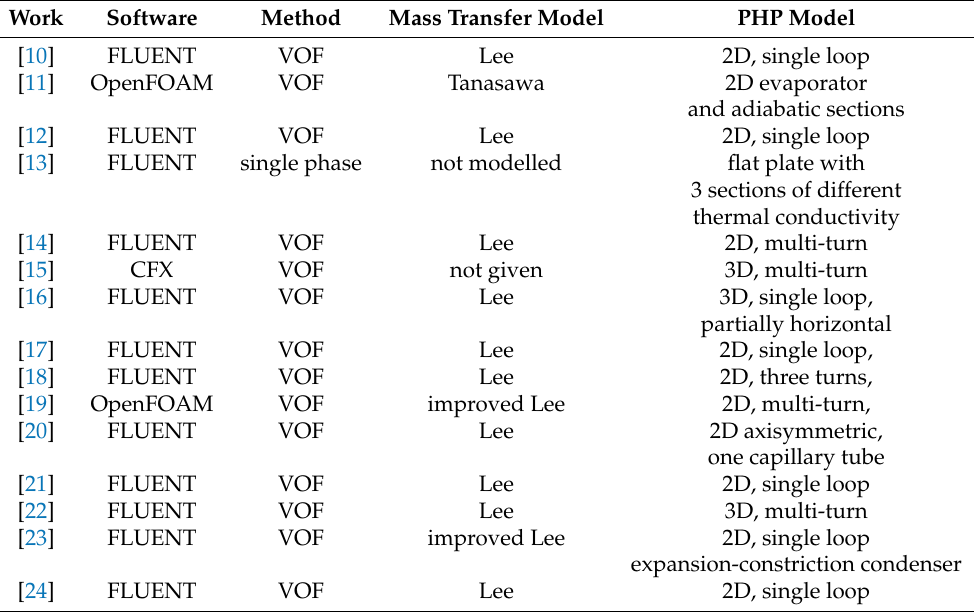
Table 1. Summary of works concerning CFD modeling of PHPs.